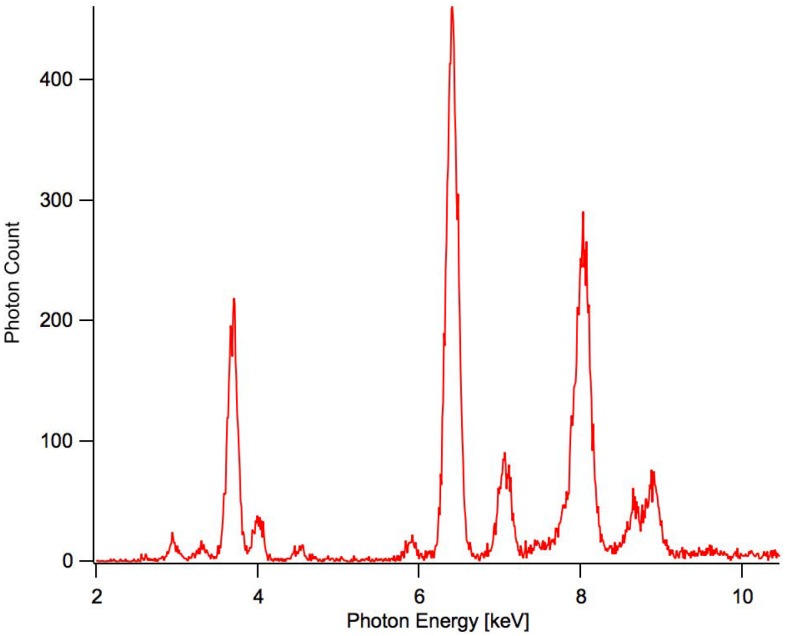
Calibration spectrum.Photon counts vs. photon energy [keV] of the SDD detector exposed to characteristic XRF emissions from a multivitamin target material for 900 seconds.